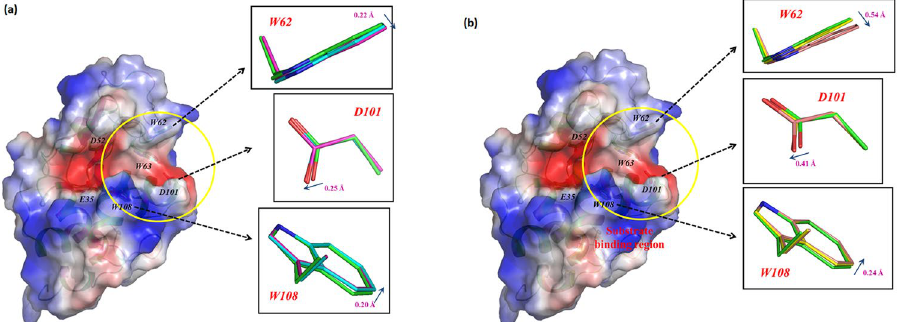
Figure 5. X-ray crystallographic structural change of substrate binding site. The structural differences between control and treatment (8 and 12 min) of ( a ) Air-DBD and ( b ) N 2 -APPJ are